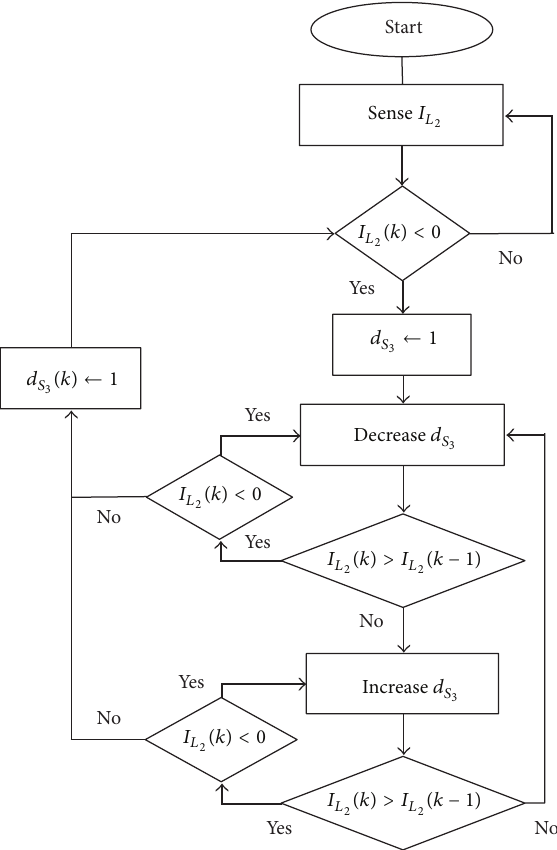
Figure 11: Flowchart of the tracking